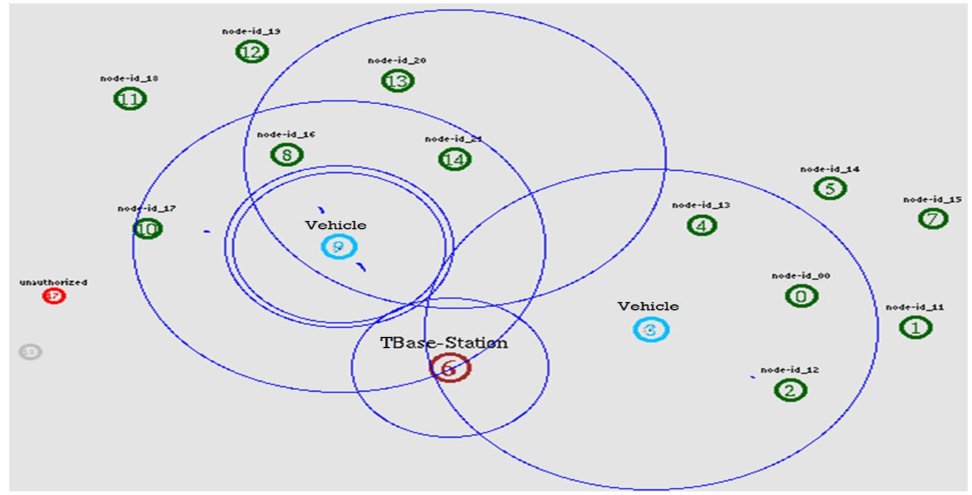
Figure 11. The scenario for performing a DoS attack.